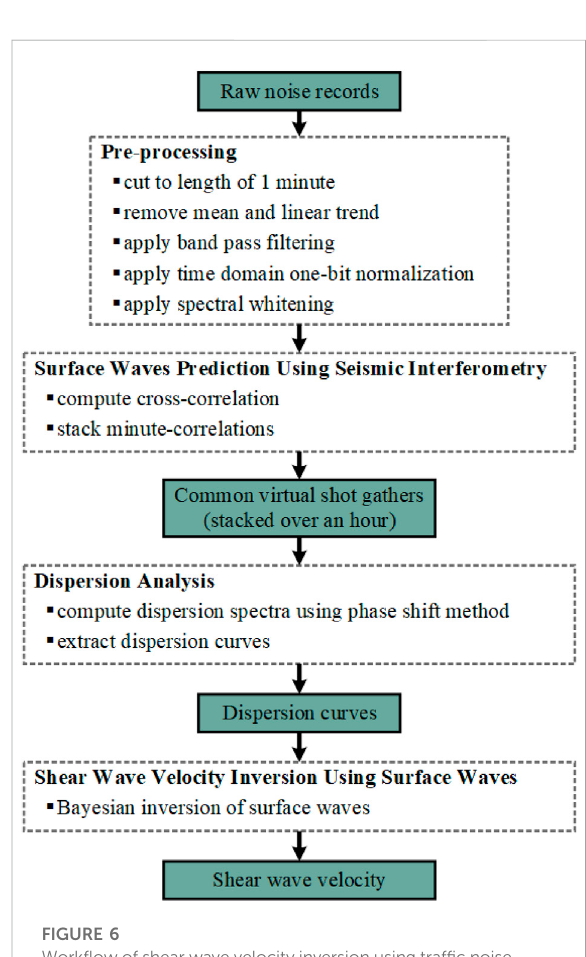
FIGURE 6 Work fl ow of shear wave velocity inversion using traf fi c